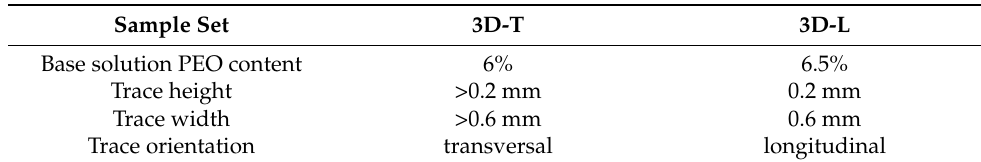
Table 1. Data for all sample sets preparation [23]. “Reprinted with permission from {Siebert, L.;